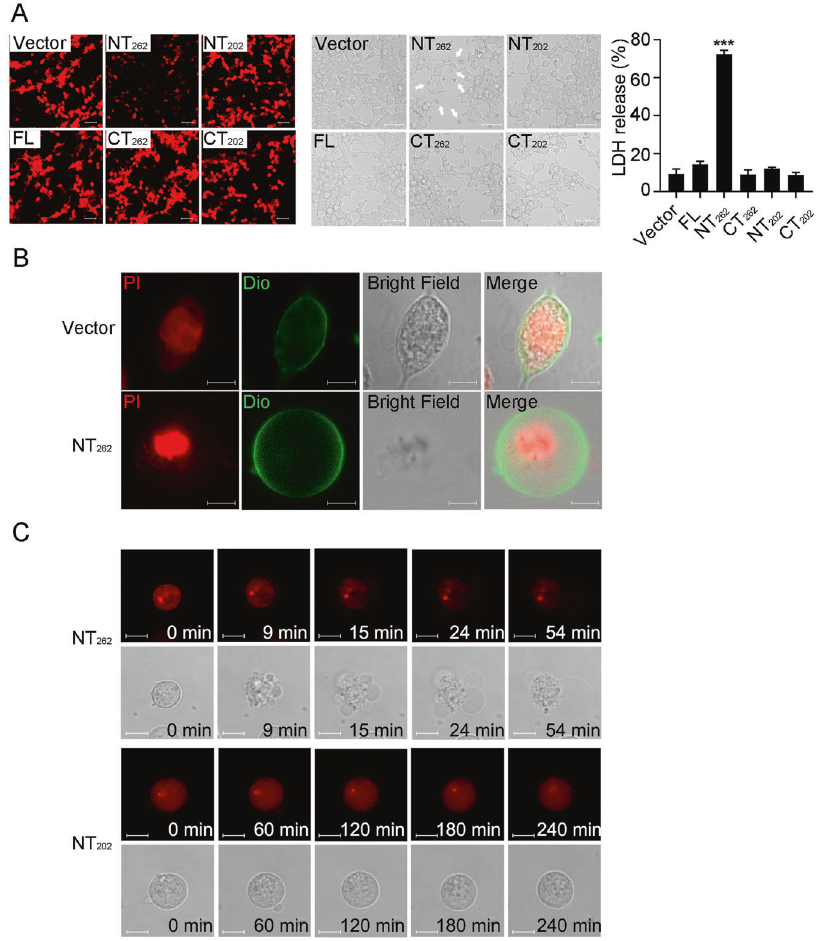
SmGSDMEa variants (left), morphological change (middle), and LDH release (right). Scale bar, 50 μ m. Values are shown as means ± SD, n = 3. *** P < 0.001. B Confocal microscopy of HKE293T cells transfected with the backbone vector or the vector expressing SmGSDMEa-NT 262 . Cell nucleus and membrane were stained with PI and DiO, respectively. Scale bar, 10 μ m. C HEK293T cells were transfected with mCherry-tagged SmGSDMEa-NT 262 (upper panel) and SmGSDMEa-NT 202 (lower panel), and time-lapse images were taken. Scale bar, 10 μ